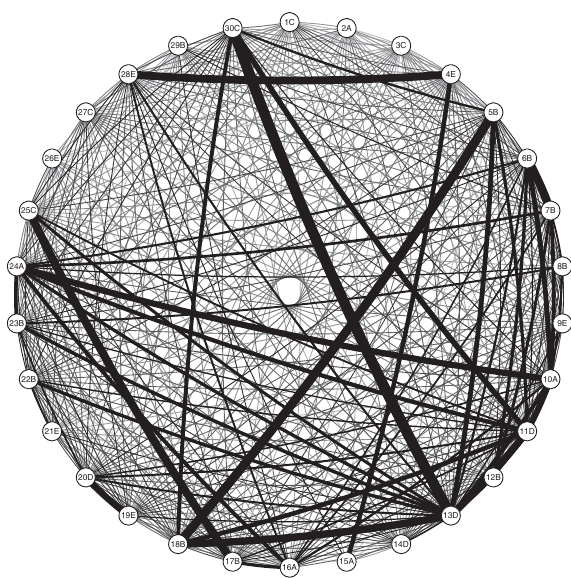
FIG. 5. The network structure of all thirty correct, Newtonian items is plotted in a circular distribution. The clockwise ordering of items represents their natural order in the inventory. The stronger the correlation the thicker the connecting line. For sake of transparency, connections with absolute value less than 0.1 are